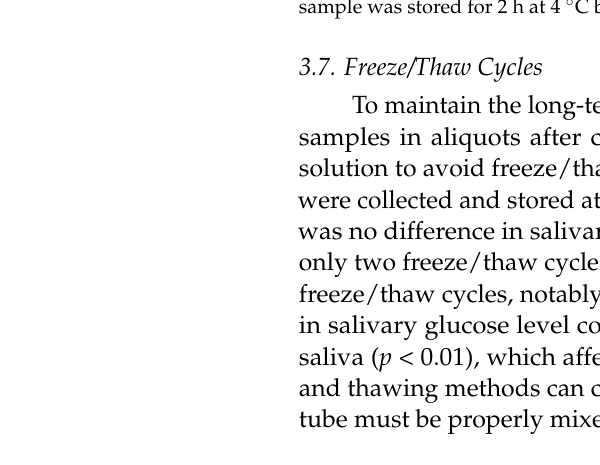
Table 6. Effects of different storage conditions on salivary glucose. (Unit: